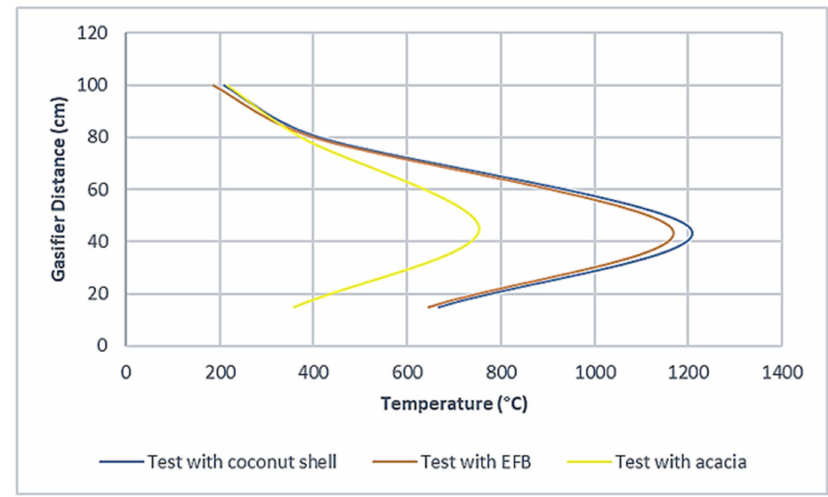
Figure 5. Temperature profile for all tests.